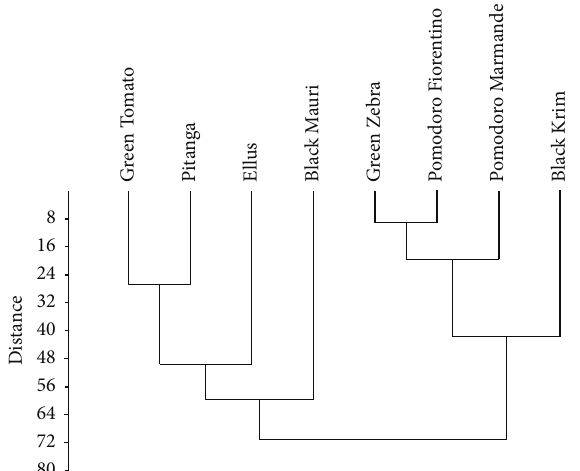
Figure 3: Similarity dendrogram of tomato genotypes associated with plant characteristics (height, flowers, fruits, and production).